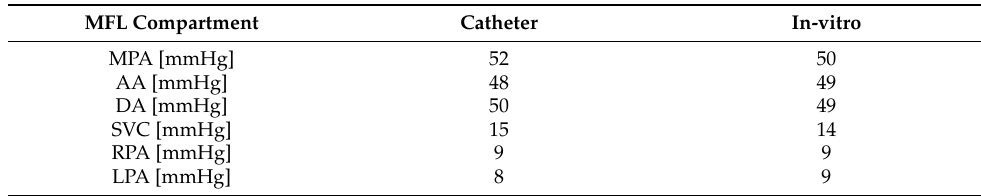
Table 9. Comparison of cycle averaged pressure [mmHg] of patient 2 between catheter reports and in-vitro